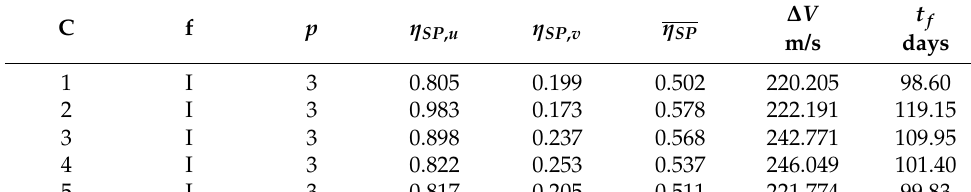
Table 3. SEL2 escapes performance—fixed C 3 = 0.5 ( km/s ) 2 , free t f .